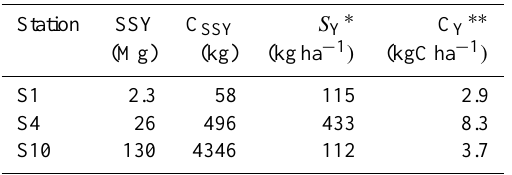
∗ S y = 10 × SSY/drainage area in Table 2; ∗∗ C − 2 × C Y = 10 SSY /drainage area in Table